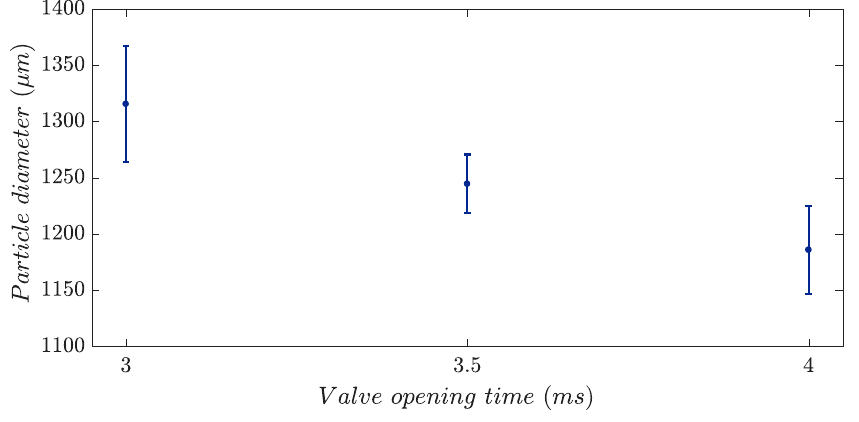
Figure 12. Process window for droplet size adjustment.